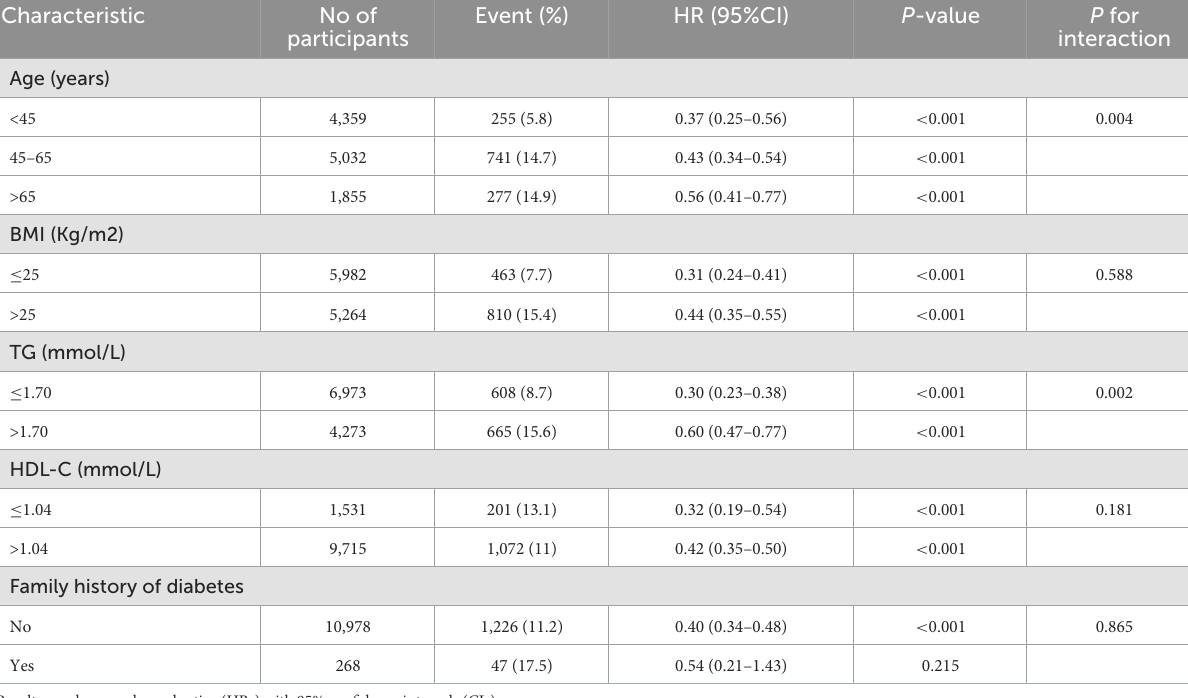
TABLE 5 Subgroup analysis between AST/ALT ratio and diabetes in participants with prediabetes.